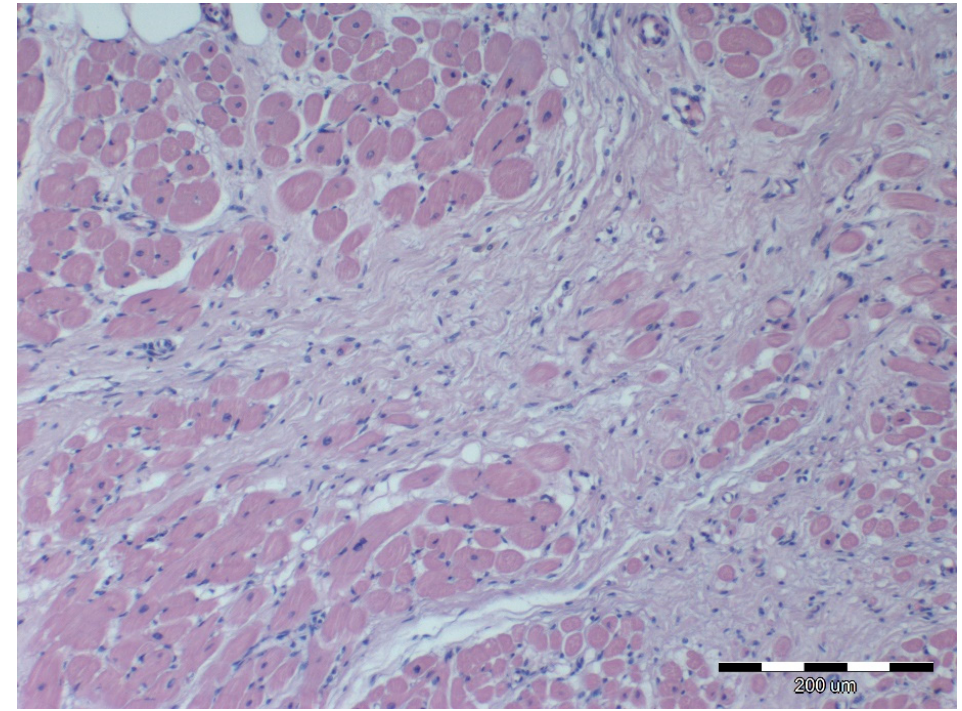
Figure 4. Microscopic image of the heart muscle specimen from an extremely obese horse. Left atrial wall: very strong extravascular fibrosis replacing normal cardiomyocytes; HE staining; 100×. In the examined group, the histopathological analysis of great arteries showed more intense disturbances in architecture and vacuolization in aorta as compared to the control group ( p = 0.02 and p = 0.03, respectively). The severity of aortic architecture disturbances in the obese group is presented in Figure 5, compared to a normal aortic wall in a lean group horse (Figure 6).